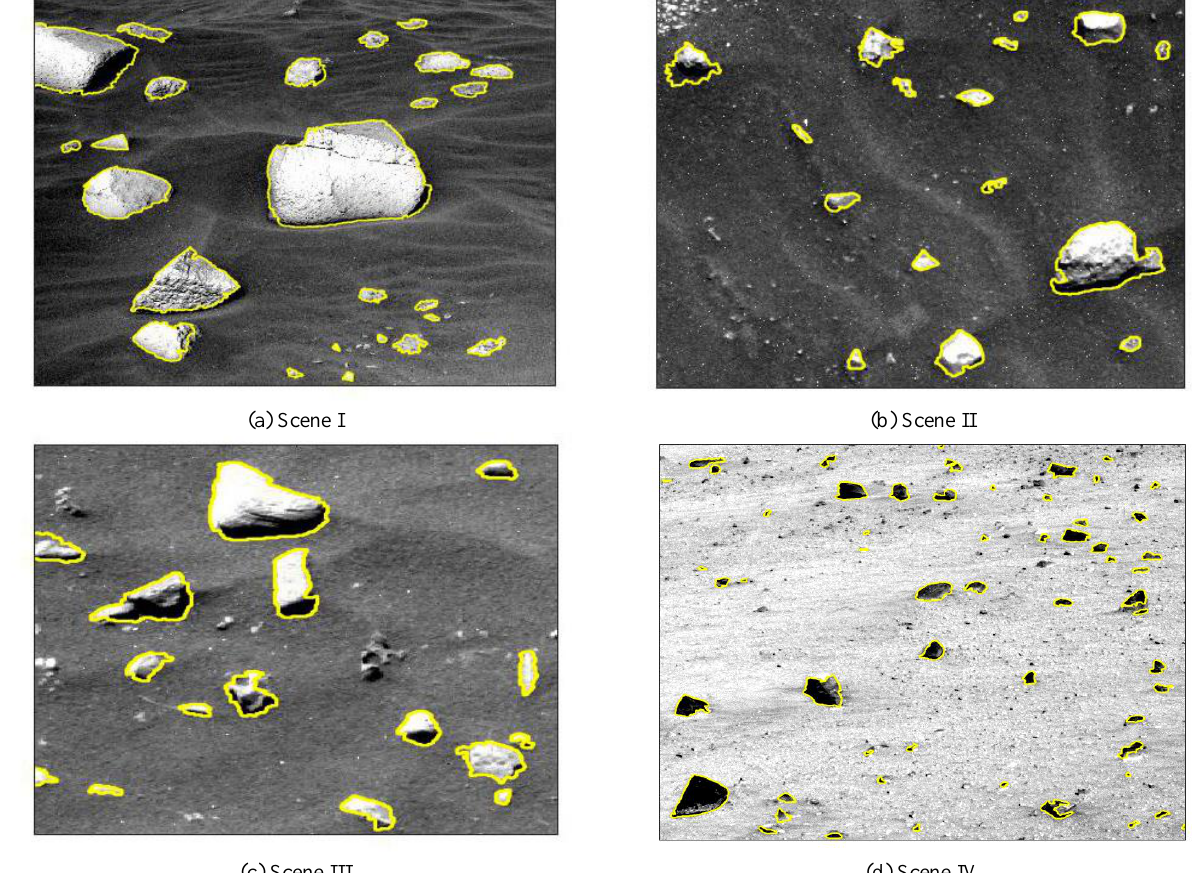
Fig. 3 Experimental results derived from the proposed method. The detected rocks are marked with yellow